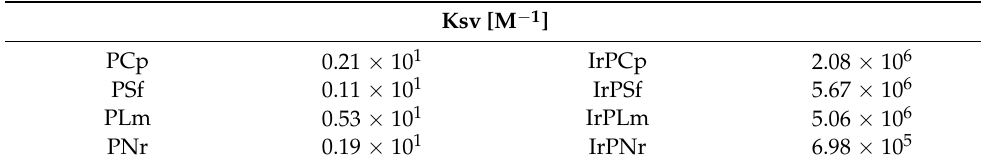
Table 3. Determined Ksv values for the studied phosphines and Ir(III)